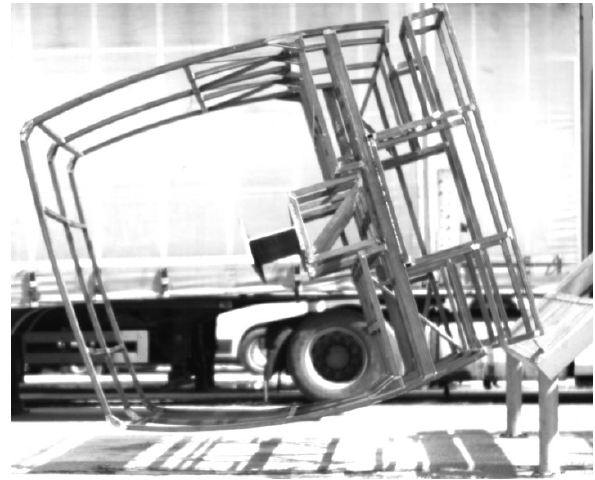
Figure 12. The safety frame 0.24 s after the beginning of the impact.